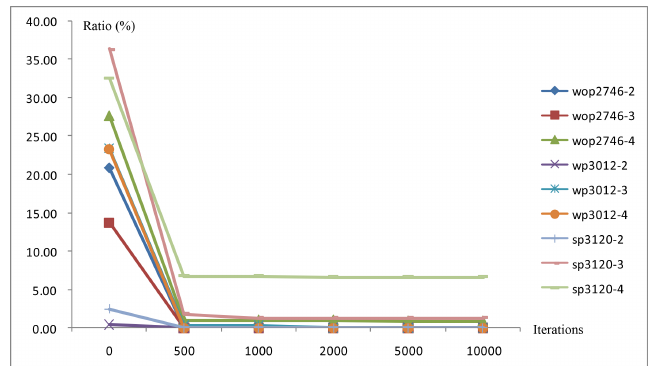
Figure 13. The convergence curves of the remaining nine instances generated by the algorithm with L = 15 .